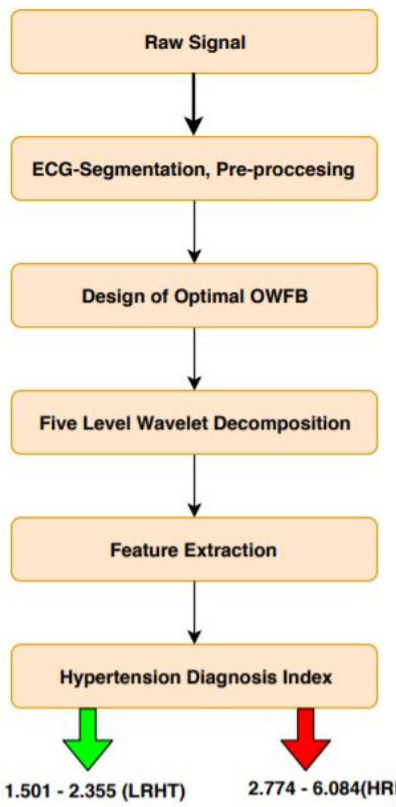
Figure 5. Workflow of the proposed work. OWFB, optimal orthogonal wavelet filter